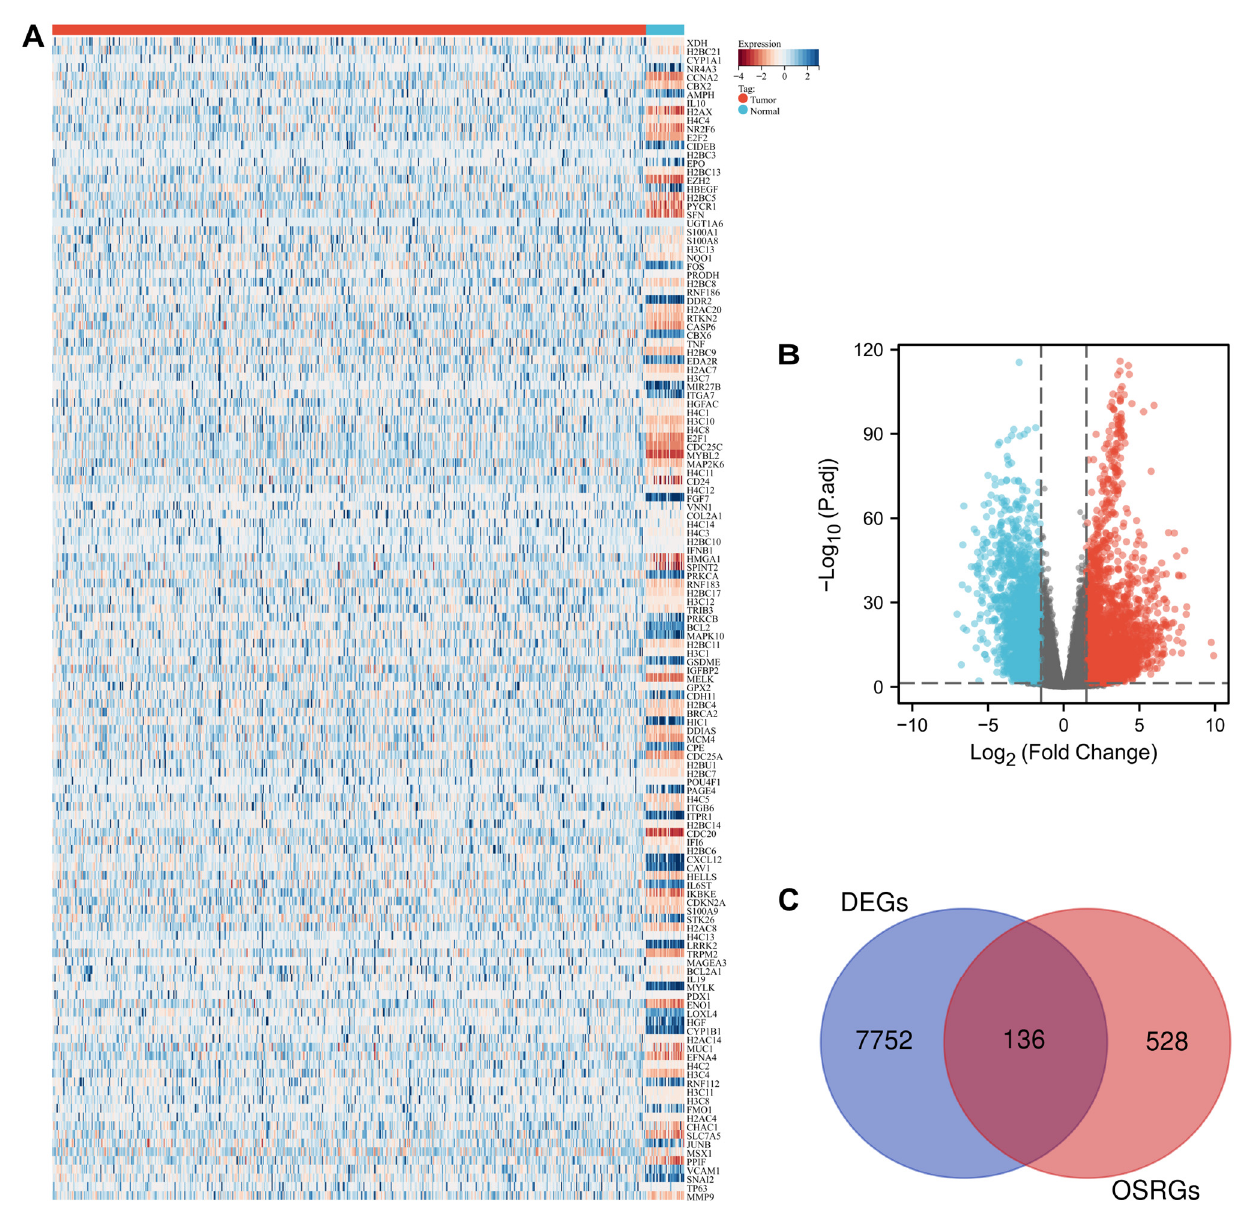
Figure 1. The DEGs associated with oxidative stress visualized with statistical significance: ( A ) heatmap of 136 differentially expressed oxidative stress-related genes in patients with UCEC; ( B ) Volcano plot of 7905 differentially expressed genes. ( C ) Venn diagram of the intersection of DEGs and oxidative stress-related genes. Note: DEGs: differentially expressed genes.